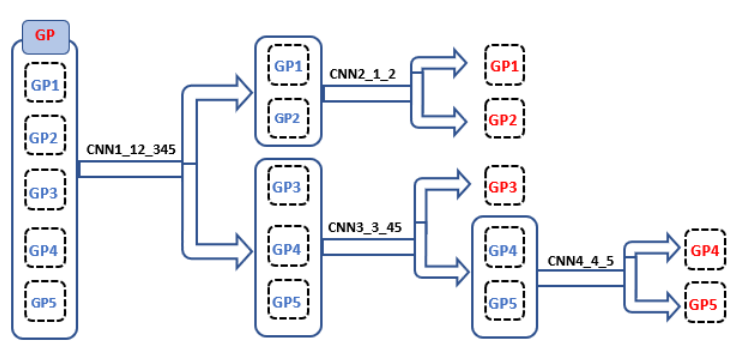
Figure 4. Schematic illustration of the multi-stage classification for the Gleason